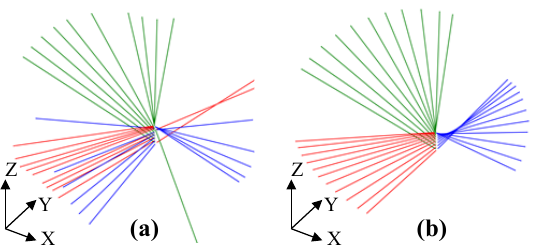
Figure 7. Example of series of principal axes (a) directly exported from TEMA3D and (b) after post-processing.